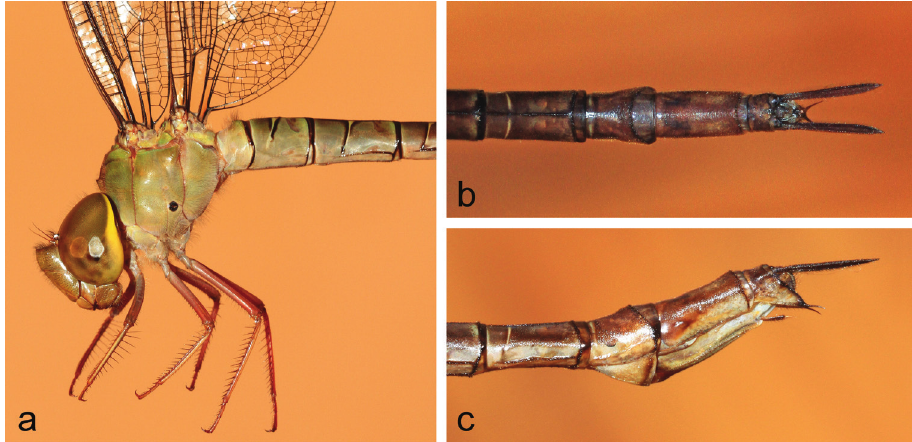
Figure 4. Gynacantha sp., a female from Chingombe, Zambia: a head, thorax and proximal segments of abdomen in lateral view b and c distal segments of abdomen with stiletto-like cerci in dorsal and lateral view (phot. B.